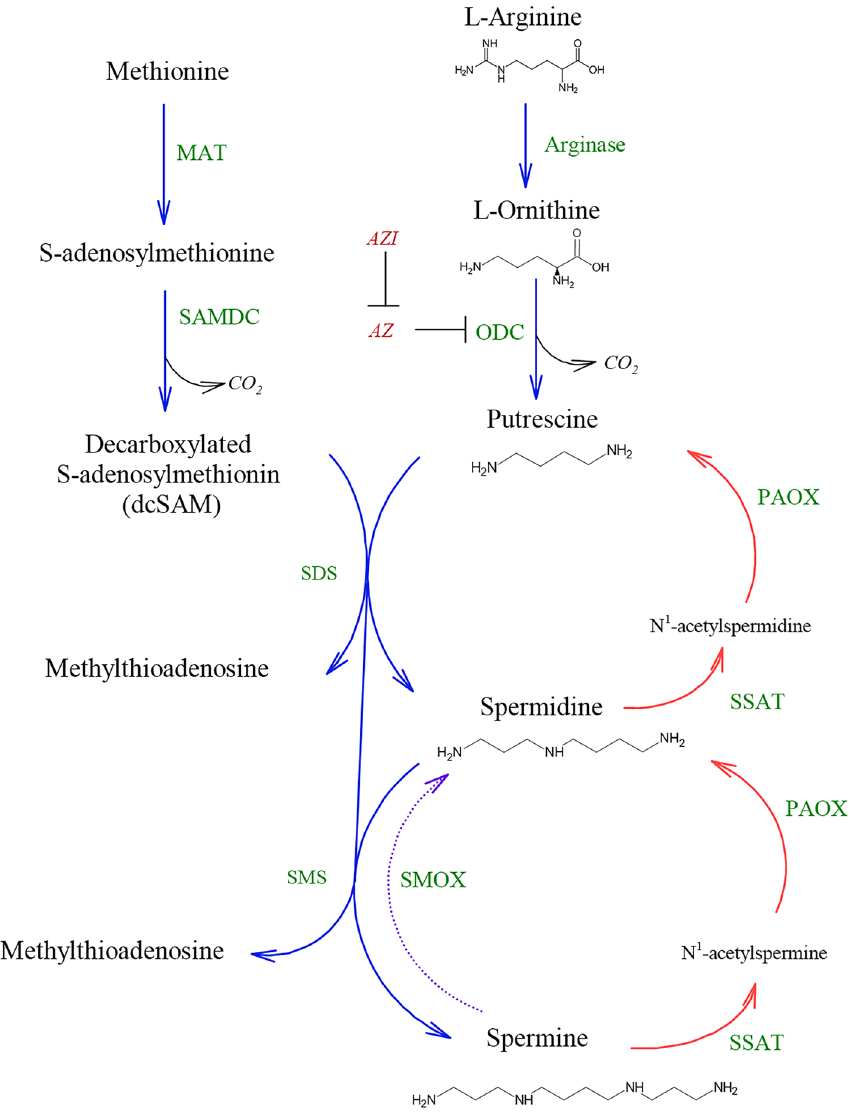
Figure 1. Polyamines metabolic pathway. Ornithine decarboxylase (ODC); spermidine synthase (SDS); spermine synthase (SMS); methyl adenosyl transferase (MAT); S-adenosyl methionine decarboxylase (SAMDC); spermine oxidase (SMOX); spermidine/spermine N1-acetyltrasferase (SSAT); polyamine oxidase (PAOX); antizyme (AZ); antizyme inhibitor